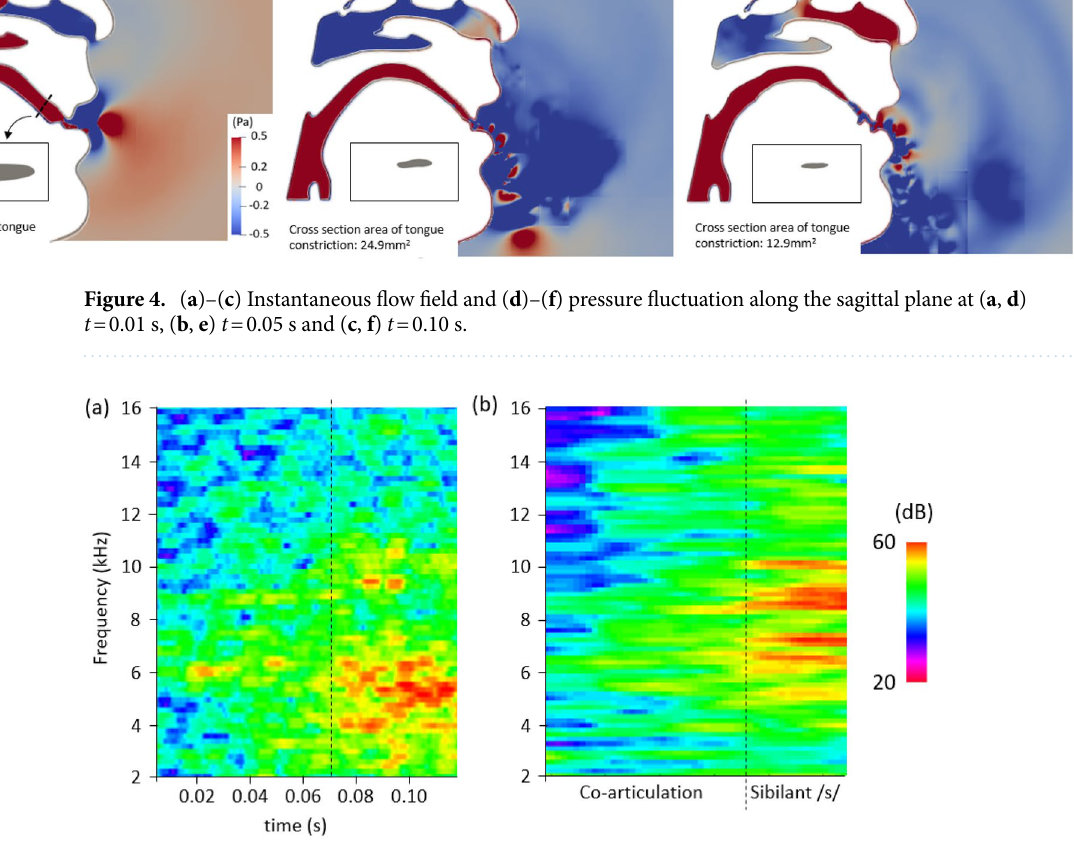
Figure 5. The spectrogram during co-articulation and sibilant /s/ sound ( a ) by the current study ( b ) measurement for the subject of the CT scan 25